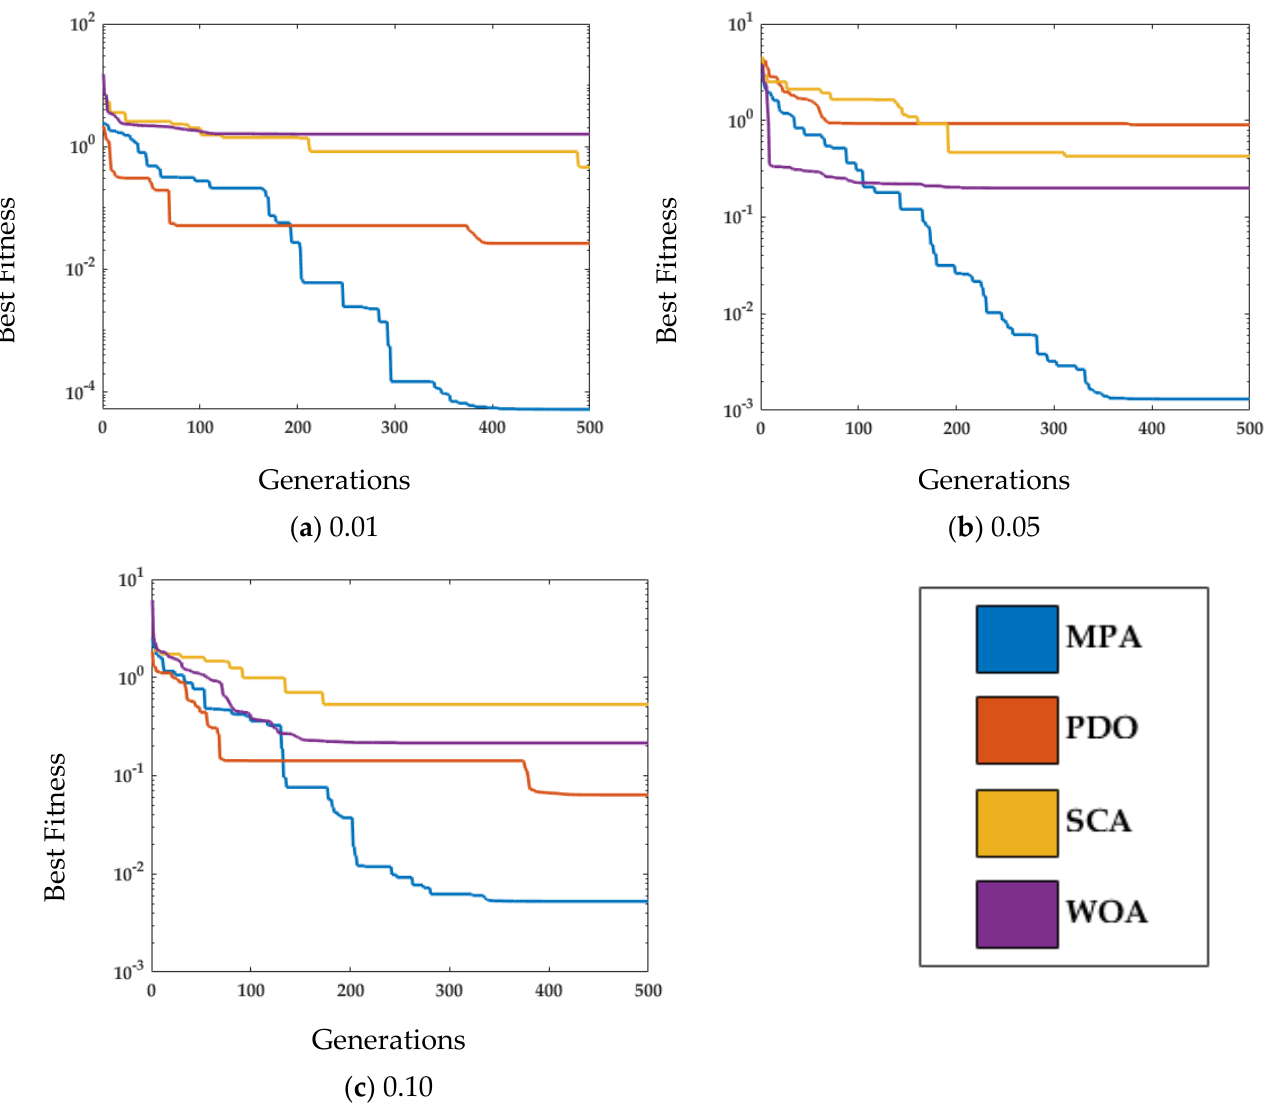
Figure 10. Fitness plots comparison of MPA with PDO, SCA, and WOA at Np = 50 and T = 500 for case study 2.